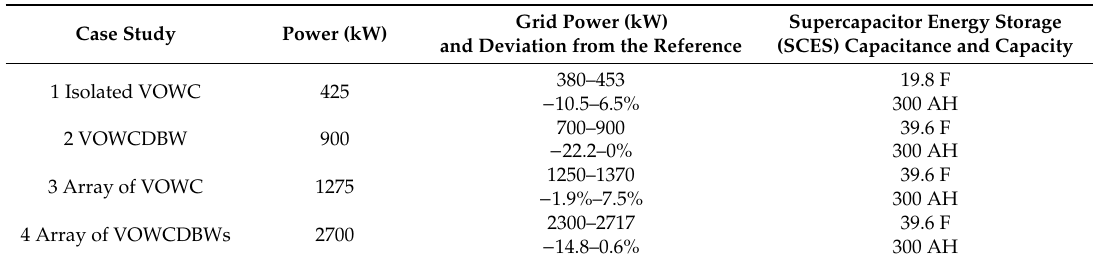
Table 2. Summary of the